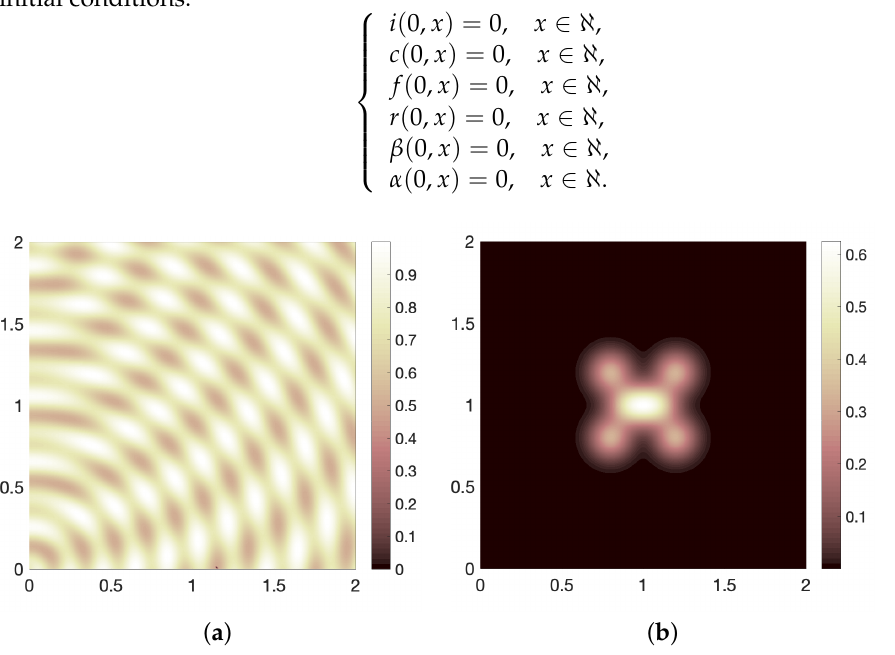
Figure 1. ( a ) Initial condition for healthy (host) cells density and ( b ) Initial condition for SARS-CoV- 2